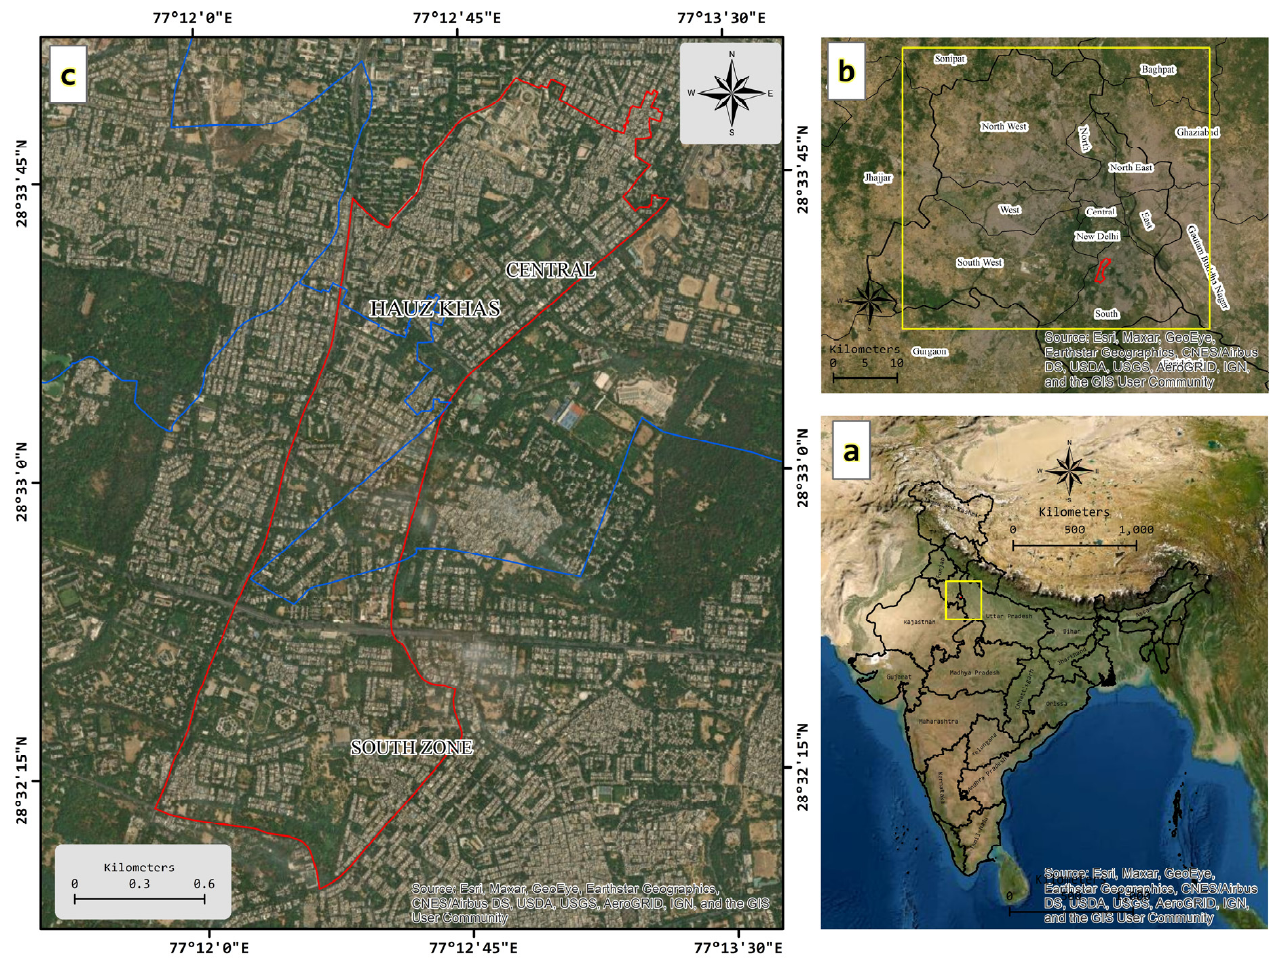
Figure 1. Location of the study area. ( a ) India, ( b ) Delhi Municipal Corporation, ( c ) Hauz Khas ward.